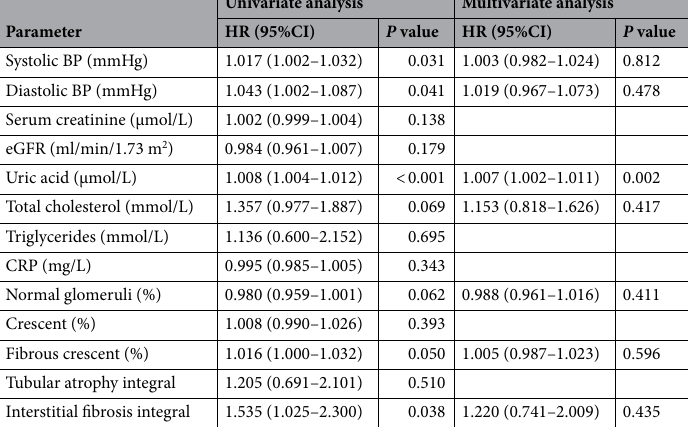
Univariate analysis Multivariate Parameter